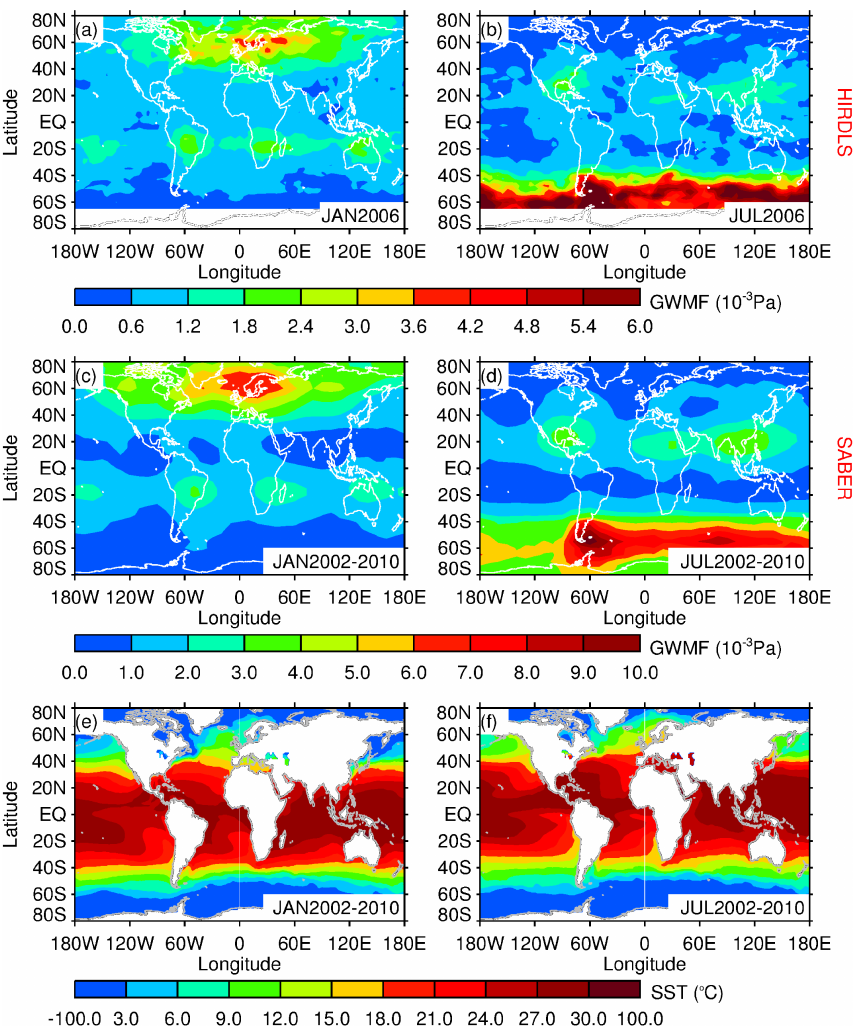
Figure 1. Global maps of GW momentum flux and SST. The left column shows values for January (southern summer) the right column for July (northern summer). GWMF for HIRDLS (upper row) and for SABER (middle row) are given at 25km altitude. HIRDLS data are from 2006, while SABER data are the climatology from 2002 to 2010. Please note the different color bars indicating that GWMF from HIRDLS is about 40% lower than GWMF from SABER. SST data (lower row) are averaged for the years 2002–2010, same as for SABER